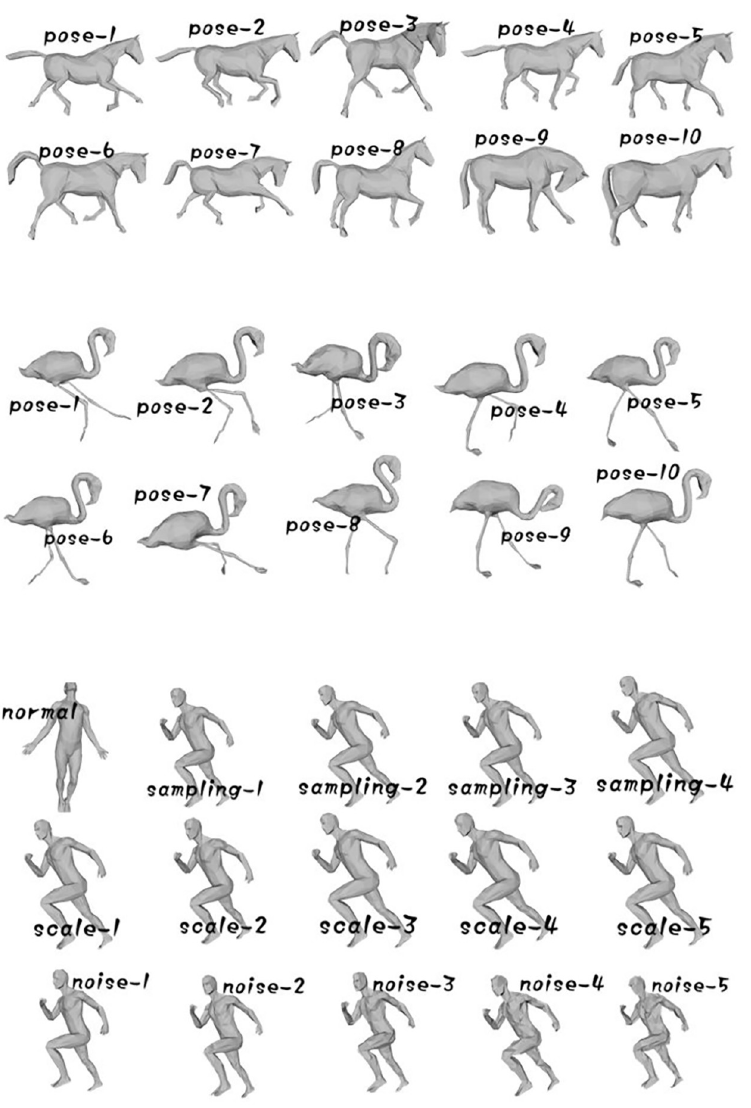
Fig 4. The model dataset used to test our algorithm. It contains 10 horse models with different poses, 10 flamingo models with different poses, and 15 human models with different sampling rates, scaling, and noise